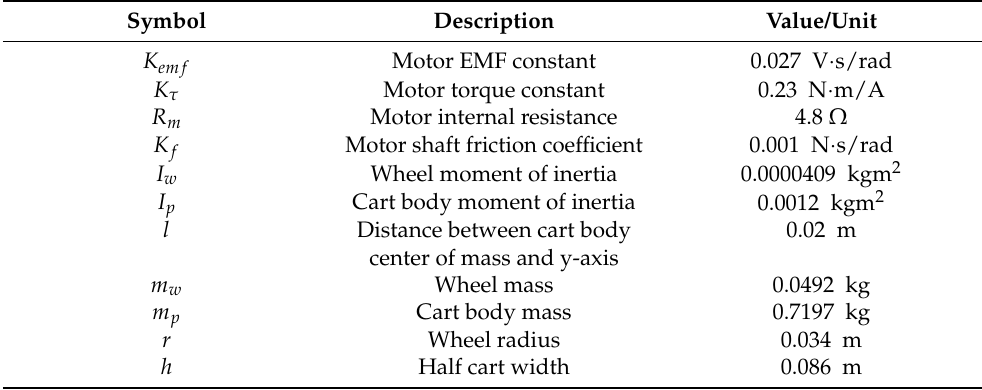
Table 1. Mini-Segway